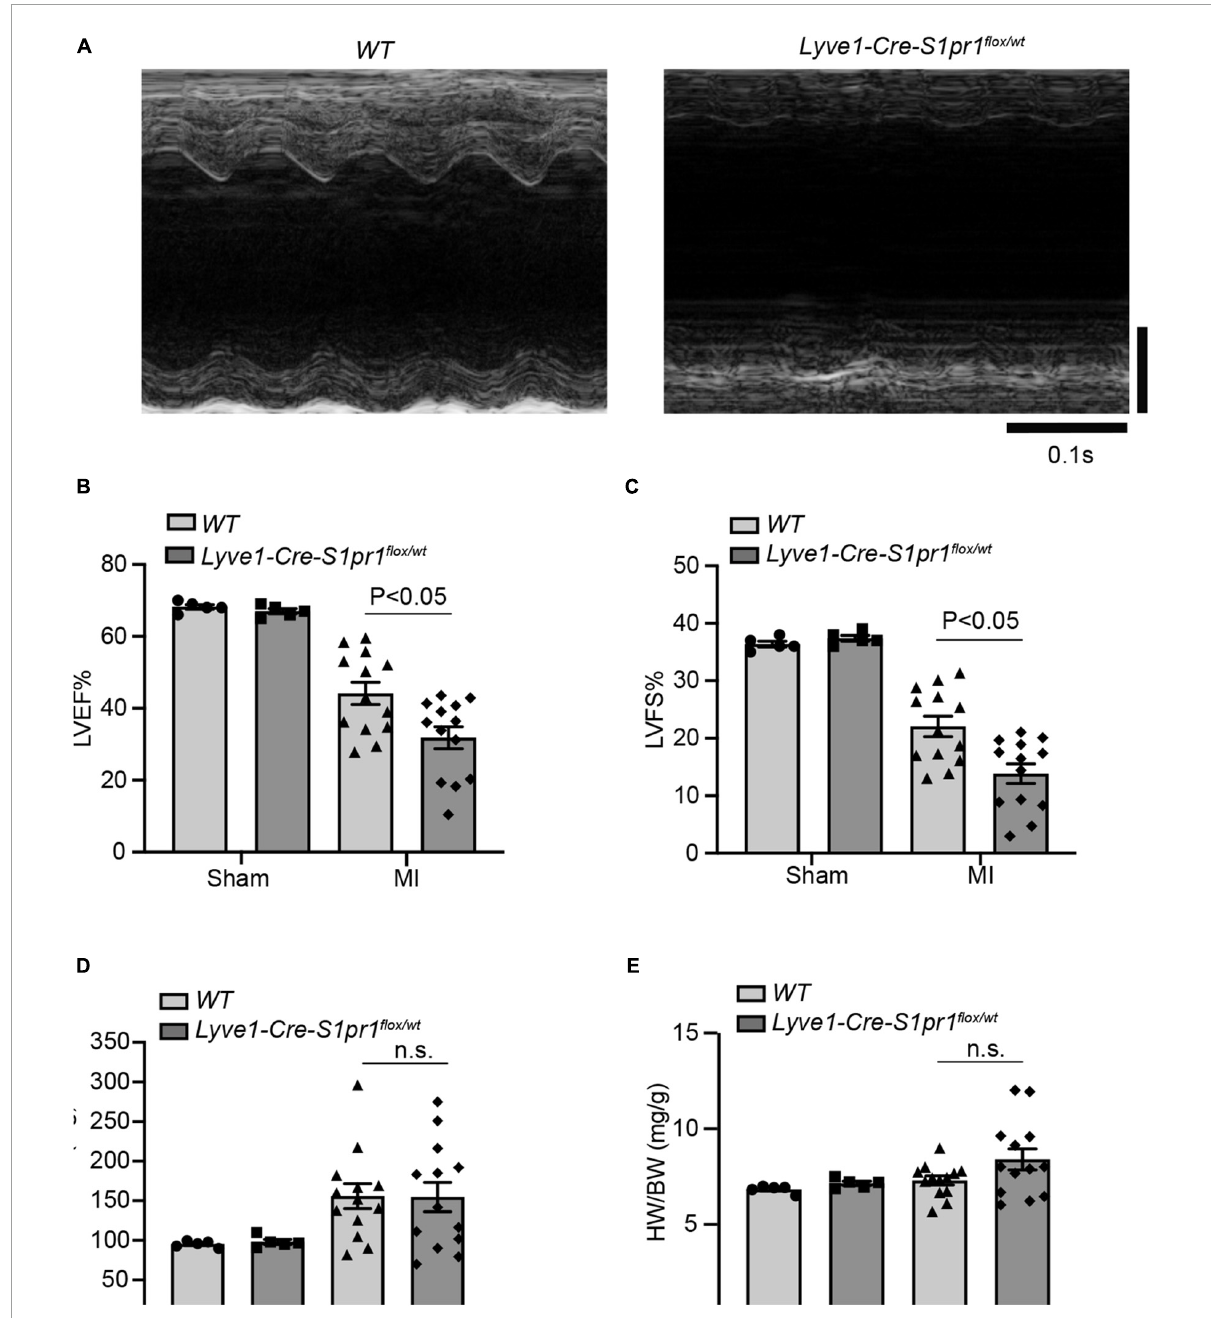
FIGURE2 The reduced expression of LEC-S1pr1 deteriorates cardiac function after acute myocardial infarction. (A–D) Representative images of echocardiography of post-MI hearts in WT and Lyve1-Cre-S1pr1 flox / wt mice (A) with quantification of left ventricle ejection fraction (LVEF%), left ventricle fractional shortening (LVFS%), and LV mass (mg) ( B,D ) ( n = 3). (E) The ratio of heart weight to bodyweight of the indicated groups (HW/BW, mg/g) ( n = 3). Data are mean ± S.E.M. n.s., no statistical significance.